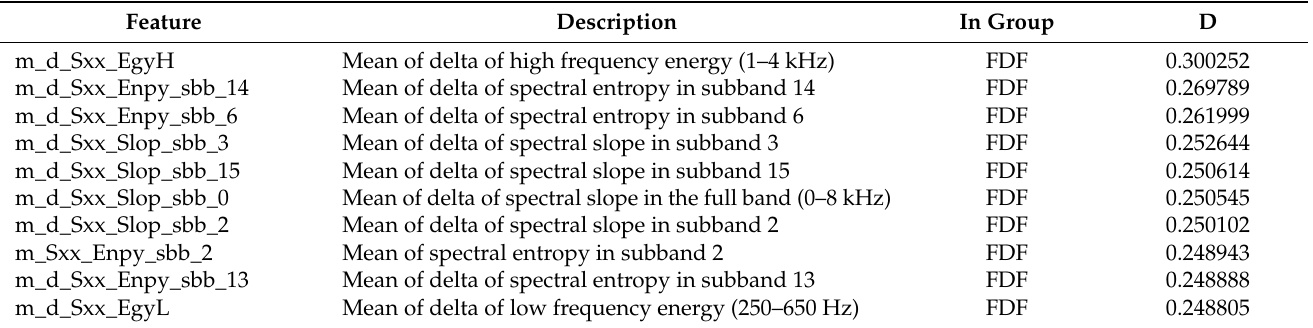
Table 6. Top 10 selected features using the proposed KS-based